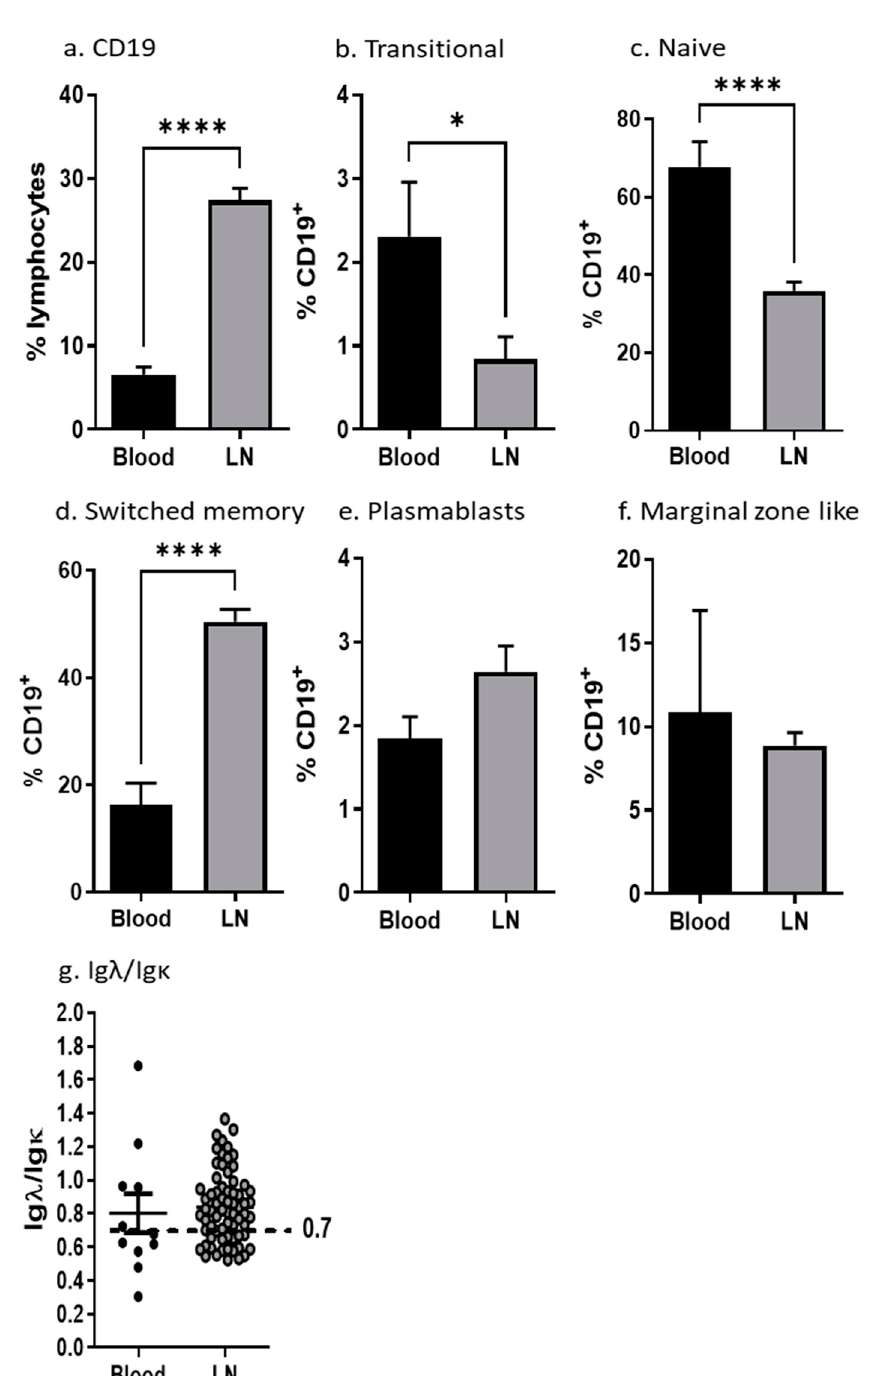
Figure 2. CD19+ B cell distribution in different cell compartments. Cells isolated from blood and lymph nodes were stained with surface markers and analyzed on a flow cytometer. ( a – f ) Mean percentages of CD19 + B cells in total lymphocytes and of the B-cell subpopulations in CD19 + lympho- cytes are shown. ( g ) Ig λ /Ig κ isotype distribution was determined by flow cytometry. The proportion is calculated by dividing Ig λ with Ig κ percentages of CD19 + cells. (n blood = 13; n LN = 74). All error bars indicate SEM. Percentages of lymphocyte subpopulations were compared with Student’s two- tailed t -test. p : * < 0.05, **** < 0.0001.